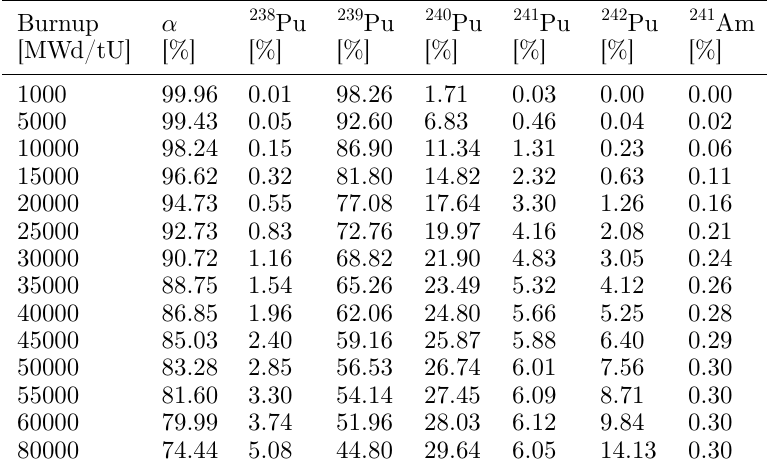
Table 2. Reference Pu vector for varying assembly discharge burnups.